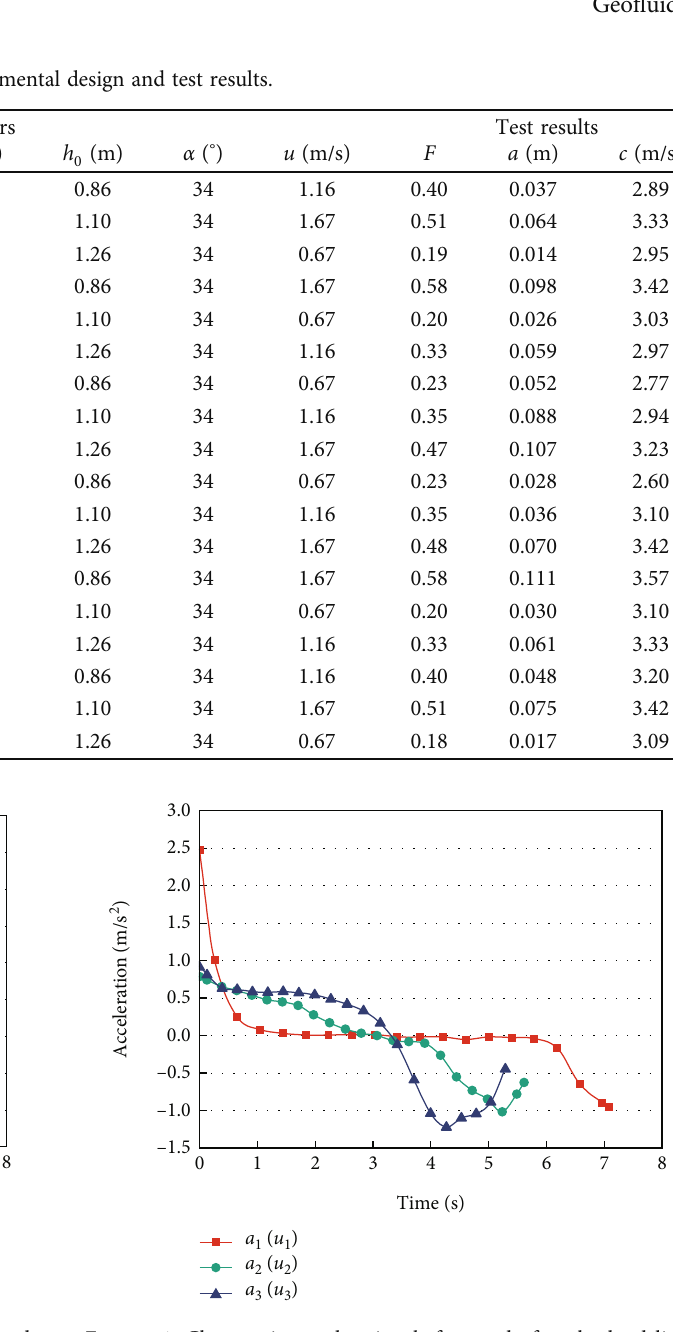
Figure 3: Changes in velocity before and after the landslide body entered the water at three sliding velocities.